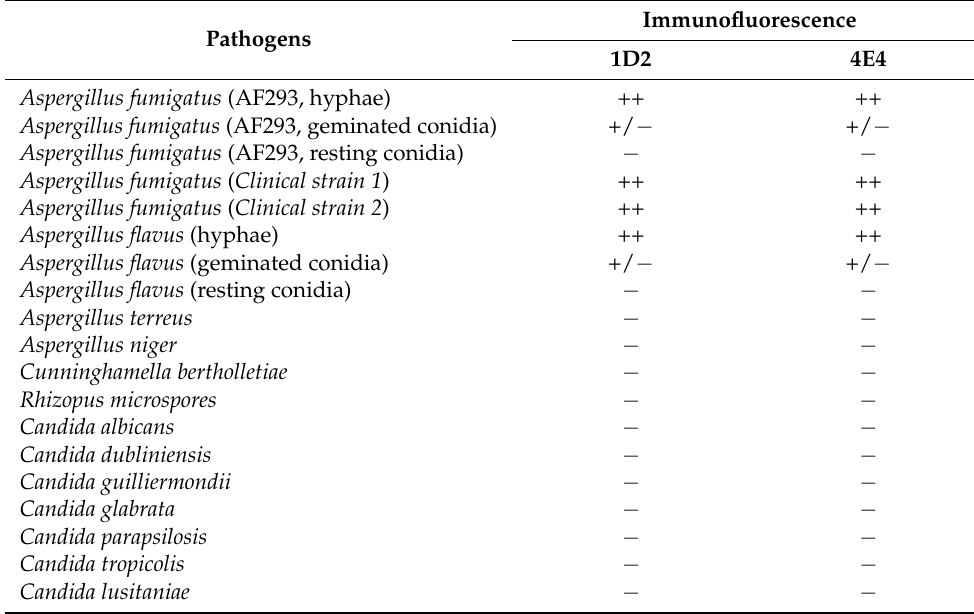
Table 1. mAbs 1D2 and 4E4 recognize only Aspergillus fumigatus and Aspergillus flavus